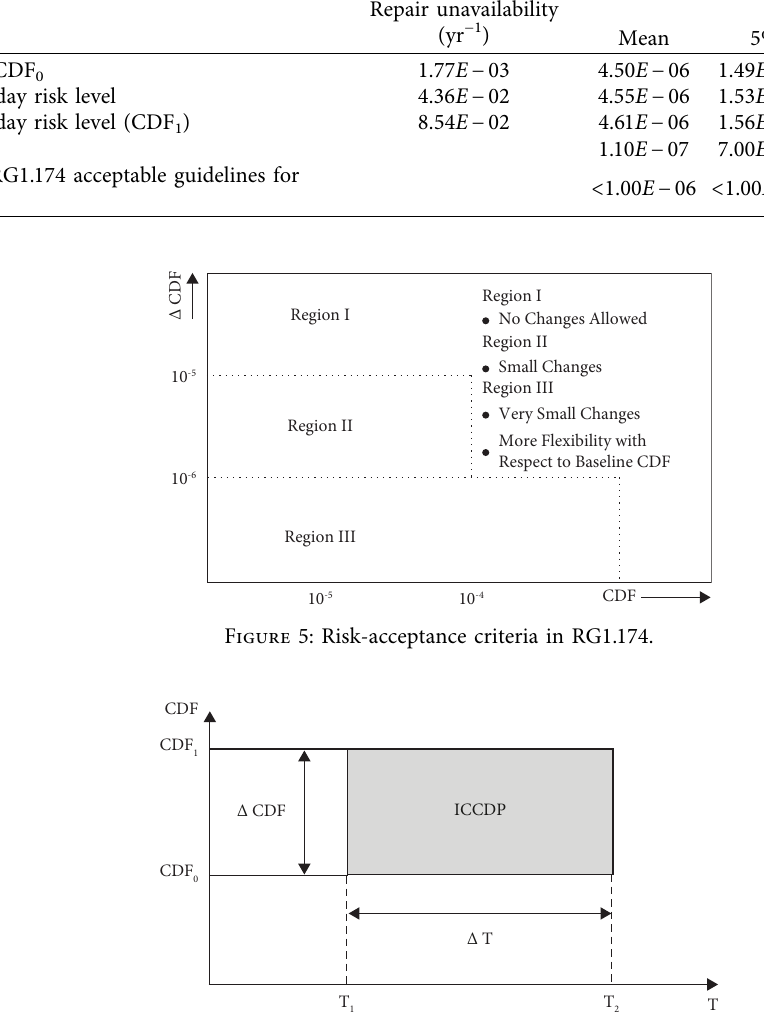
Figure 6: Schematic diagram of the ICCDP